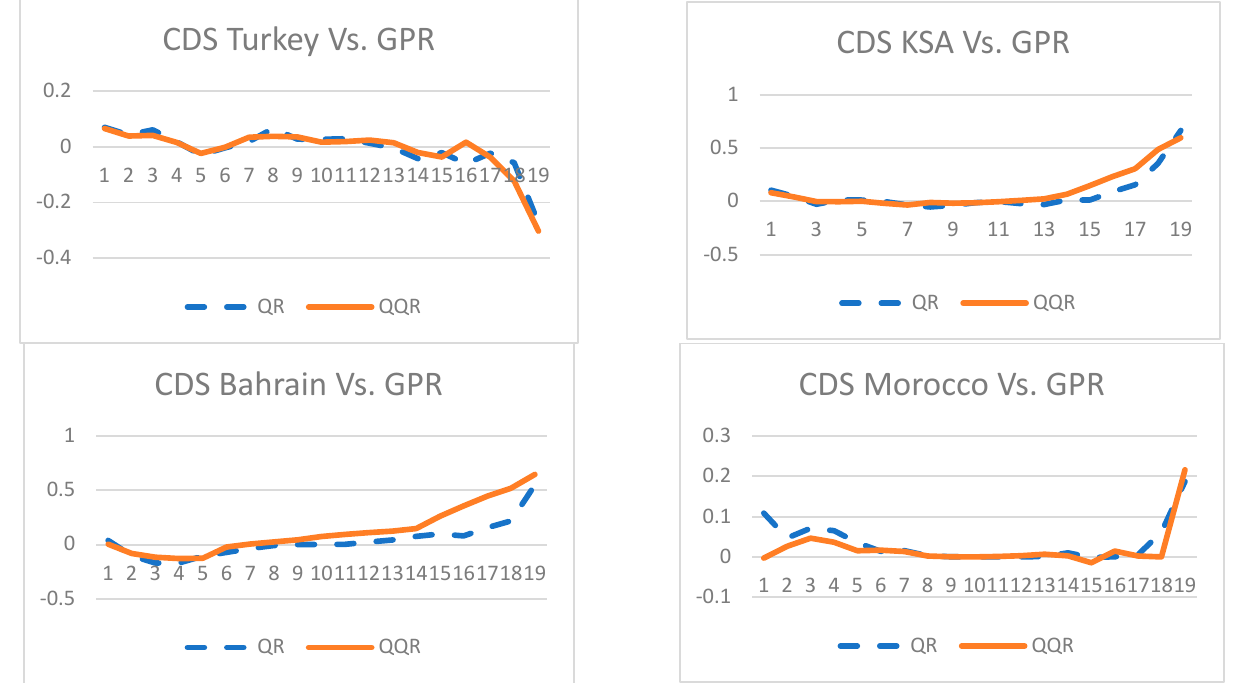
Figure 4. The comparison between the quantile-on-quantile approach (QQA) and the quantile regression (QR). ( a ): The comparison between (QQA) and the (QR) in the case of European countries. ( b ): The comparison between (QQA) and the (QR) in the case of American countries. ( c ): The comparison between (QQA) and the (QR) in the case of Asia and African countries.